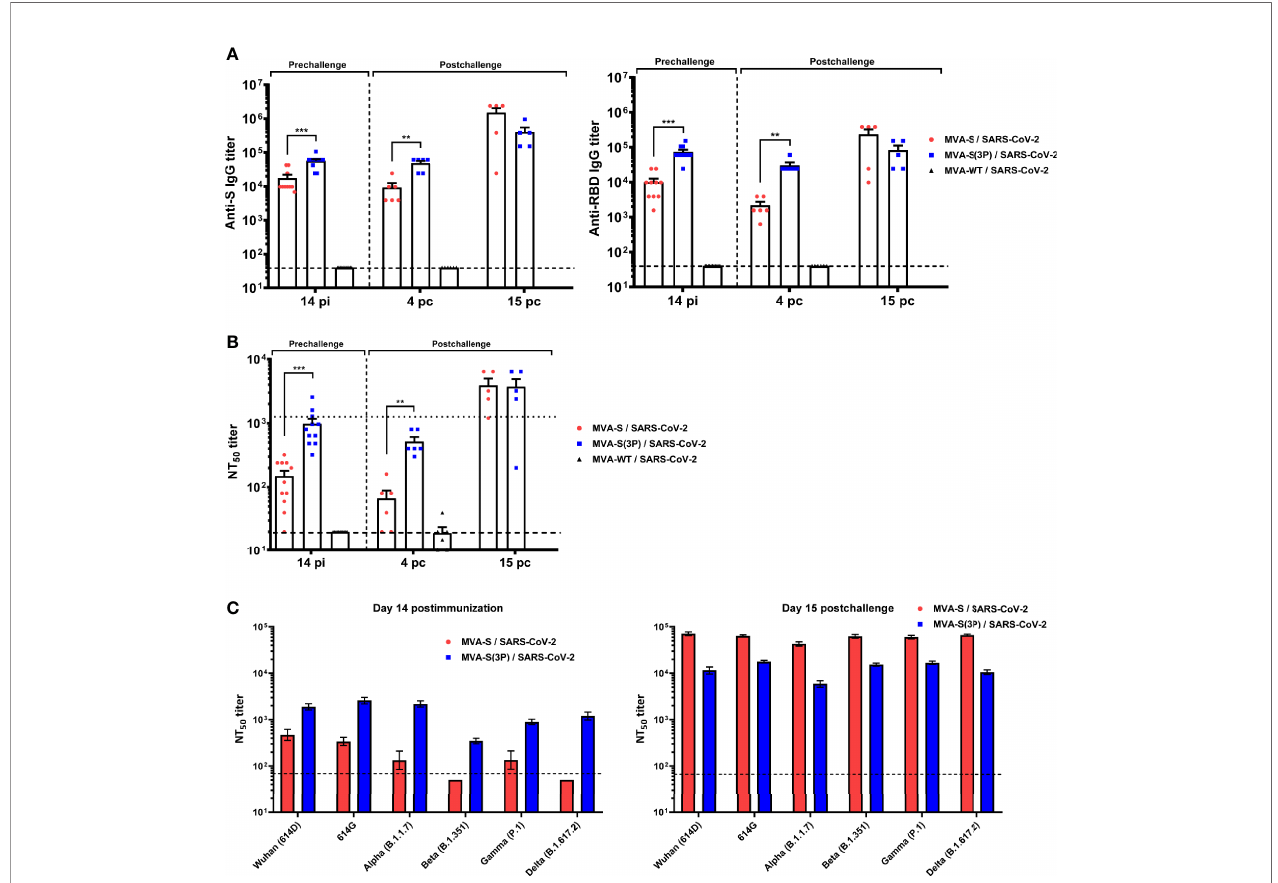
FIGURE 6 | MVA-S(3P) vaccine candidate induced high levels of humoral responses in vaccinated and challenged K18-hACE2 transgenic mice. (A) Titers of IgG antibodies speci fi c for the S (left) and RBD (right) proteins (Wuhan strain). Determined by ELISA in individual mouse serum samples collected at day 14 postimmunization (pi) (prechallenge; n = 11/group) and at days 4 ( n = 6/group) and 15 ( n = 5/group) postchallenge (pc) from K18-hACE2 mice. Mean values and SEM are represented. Dashed line represents the limit of detection. (B) SARS-CoV-2 neutralizing antibody titers. NT 50 titers were evaluated in individual mouse serum samples collected at day 14 pi and at days 4 and 15 pc, using a live virus microneutralization assay (MAD6 strain, having D614G mutation). Mean NT 50 values and SEM are represented. Upper dotted line represents the levels obtained with the NIBSC 20/136 international standard plasma (containing pooled plasma obtained from 11 individuals recovered from SARS-CoV-2 infection). Bottom dotted line represented the limit of detection. (C) SARS-CoV-2 neutralizing antibody titers against SARS-CoV-2 VoC. NT 50 titers were evaluated in pooled mouse serum samples collected at days 14 pi (left) and 15 pc (right), using VSV-based pseudoparticles expressing the SARS-CoV-2 S protein of different VoC. Mean NT 50 values and 95% con fi dence intervals are represented. Dashed line represents the limit of detection. Student ’ s t -test: ** p < 0.005; *** p <